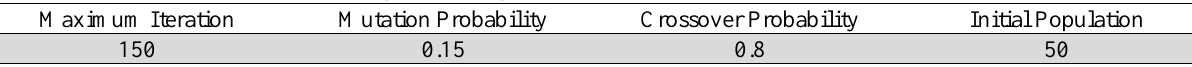
Parameter values for small scale genetic